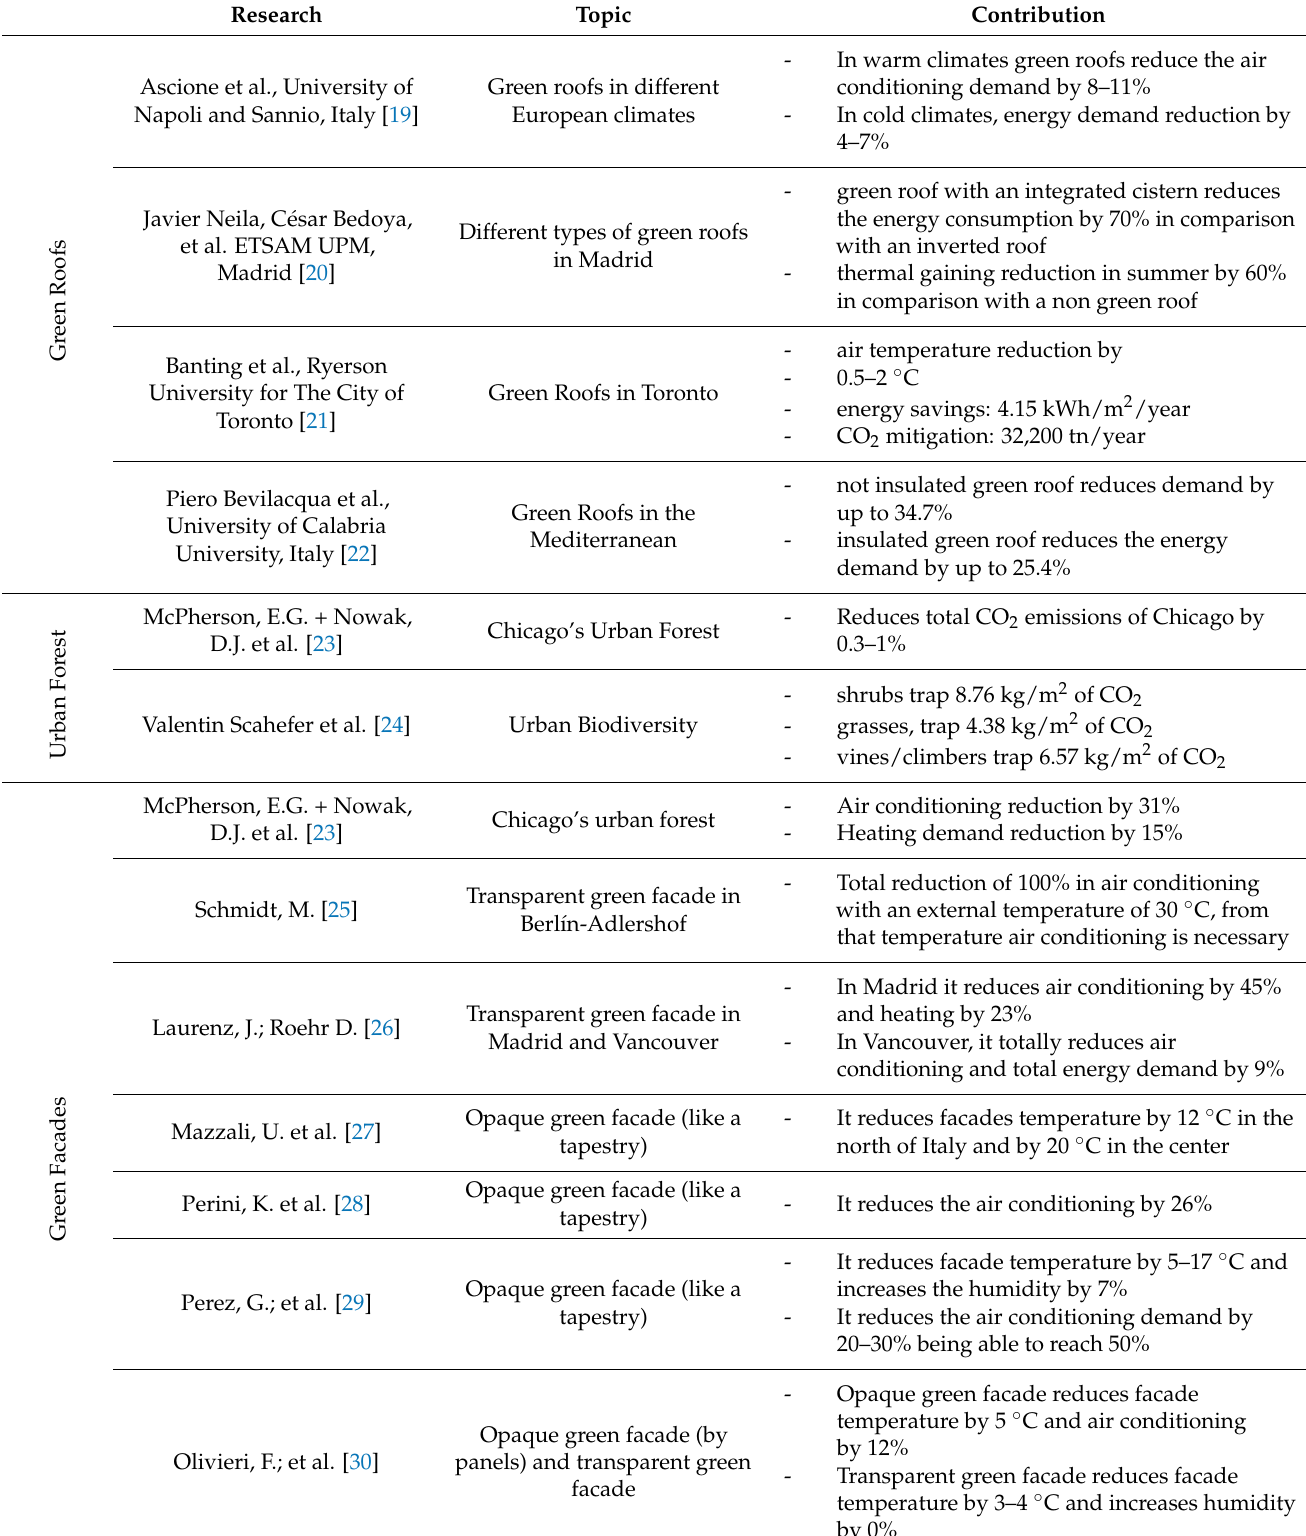
Table A1. Summary table of the contribution to CC mitigation (developed by the authors). Research